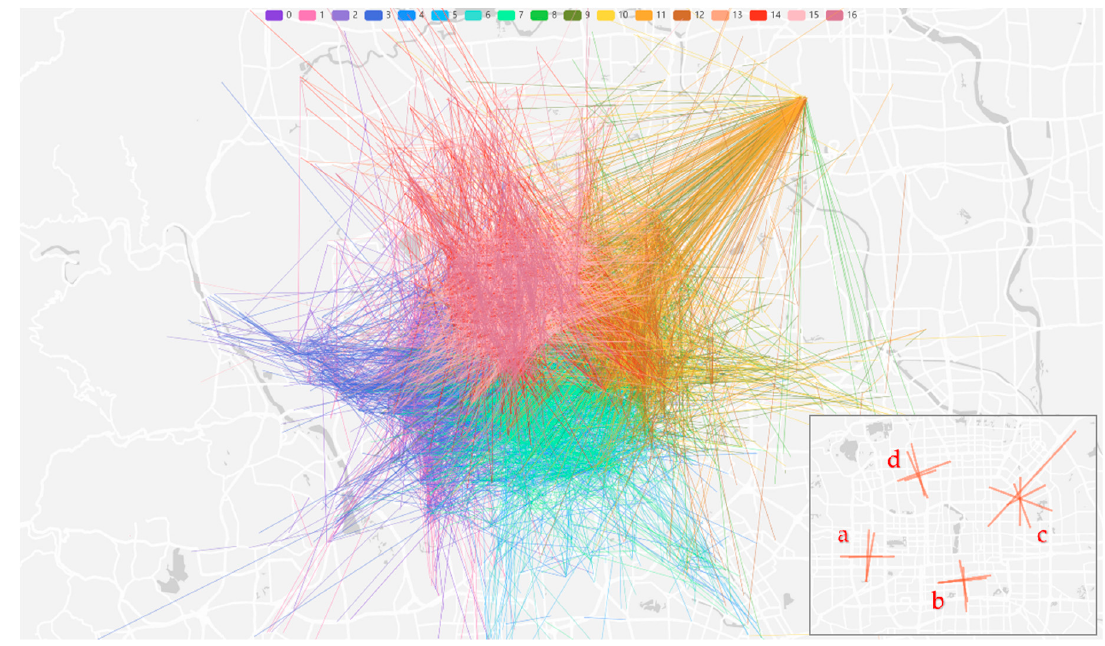
Figure 9. Four taxi OD flow spatial clusters and communities based on OD flow event point clustering process. Spatial clusters ( a ), ( b ) and ( d ) contain four vector clusters respectively, and spatial cluster ( c ) contains five vector clusters.